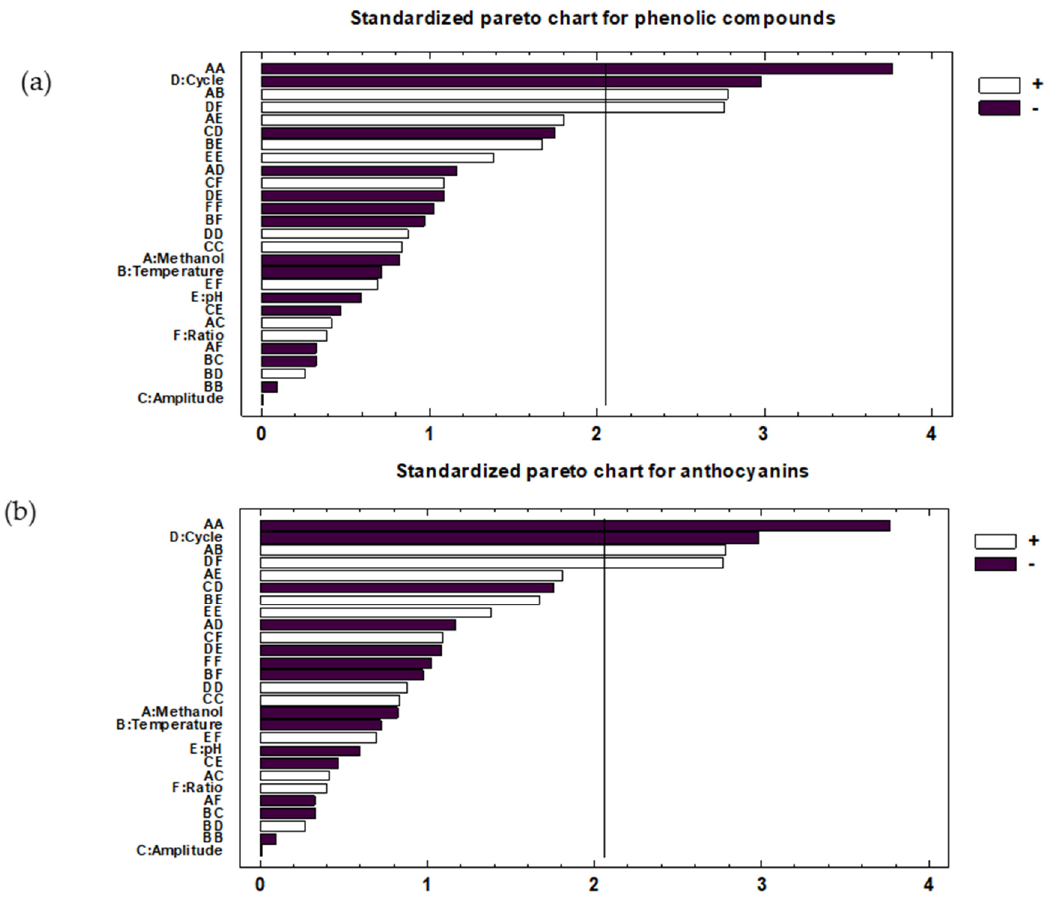
Figure 1. Pareto charts of the standardized effects: ( a ) Total phenolic compounds and ( b ) total anthocyanins.